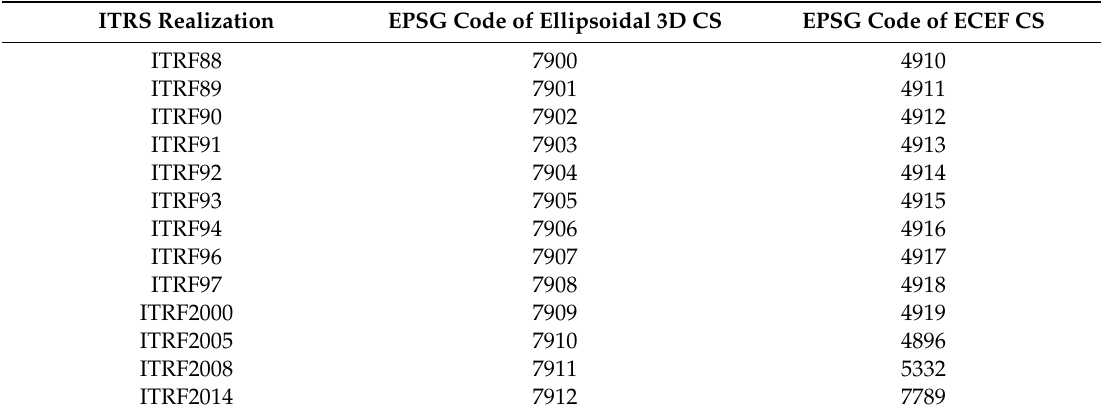
Table 1. List of EPSG codes of International Terrestrial Reference System (ITRS) realizations. CS, coordinate systems.